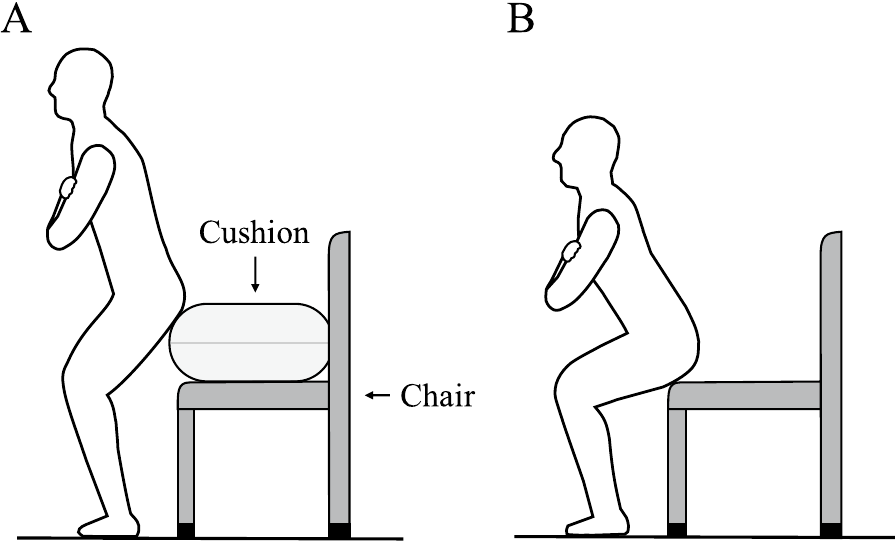
Figure 1. Representaative image of shallow squat ( A ) and deep squat ( B ) using chair and